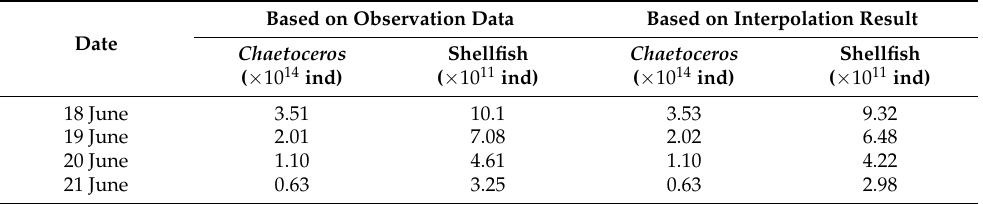
Table 3. The daily death and the total death of Chaetoceros and shellfish from June 18 to June 21 based on observation data and interpolation